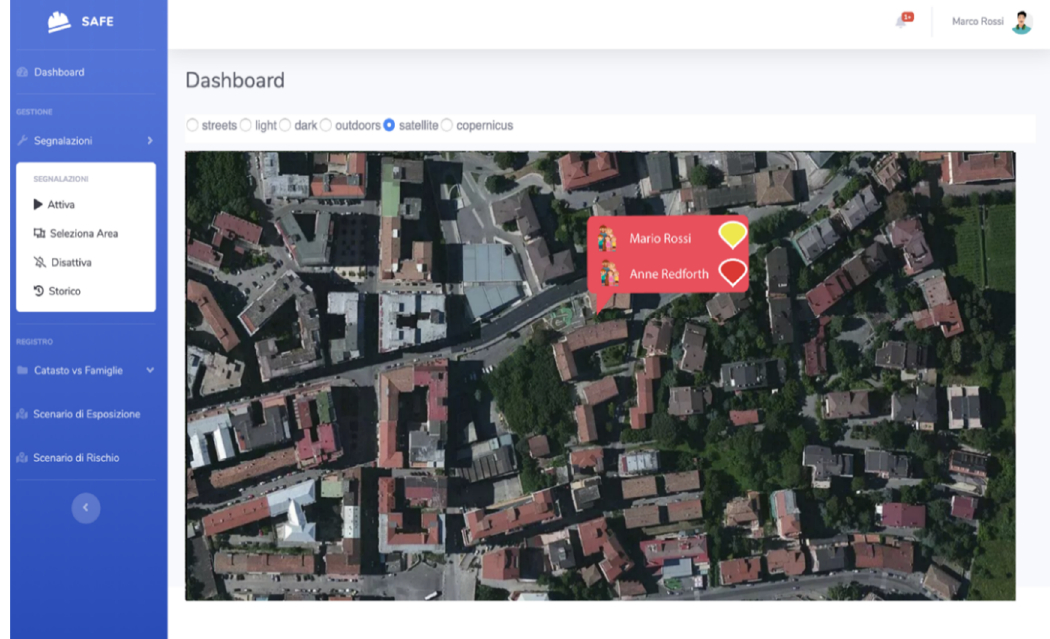
Figure 20. The states associated to the Family geometaphors.